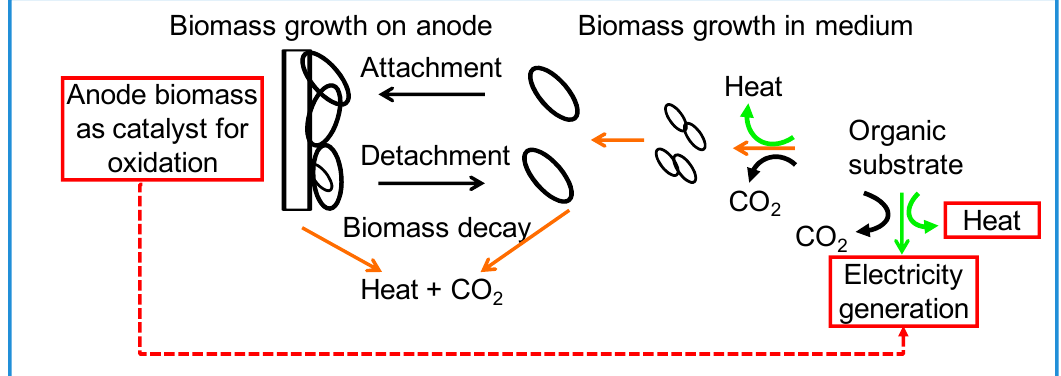
Figure 1. A schematic of organic substrate and energy flow in a microbial fuel cell.